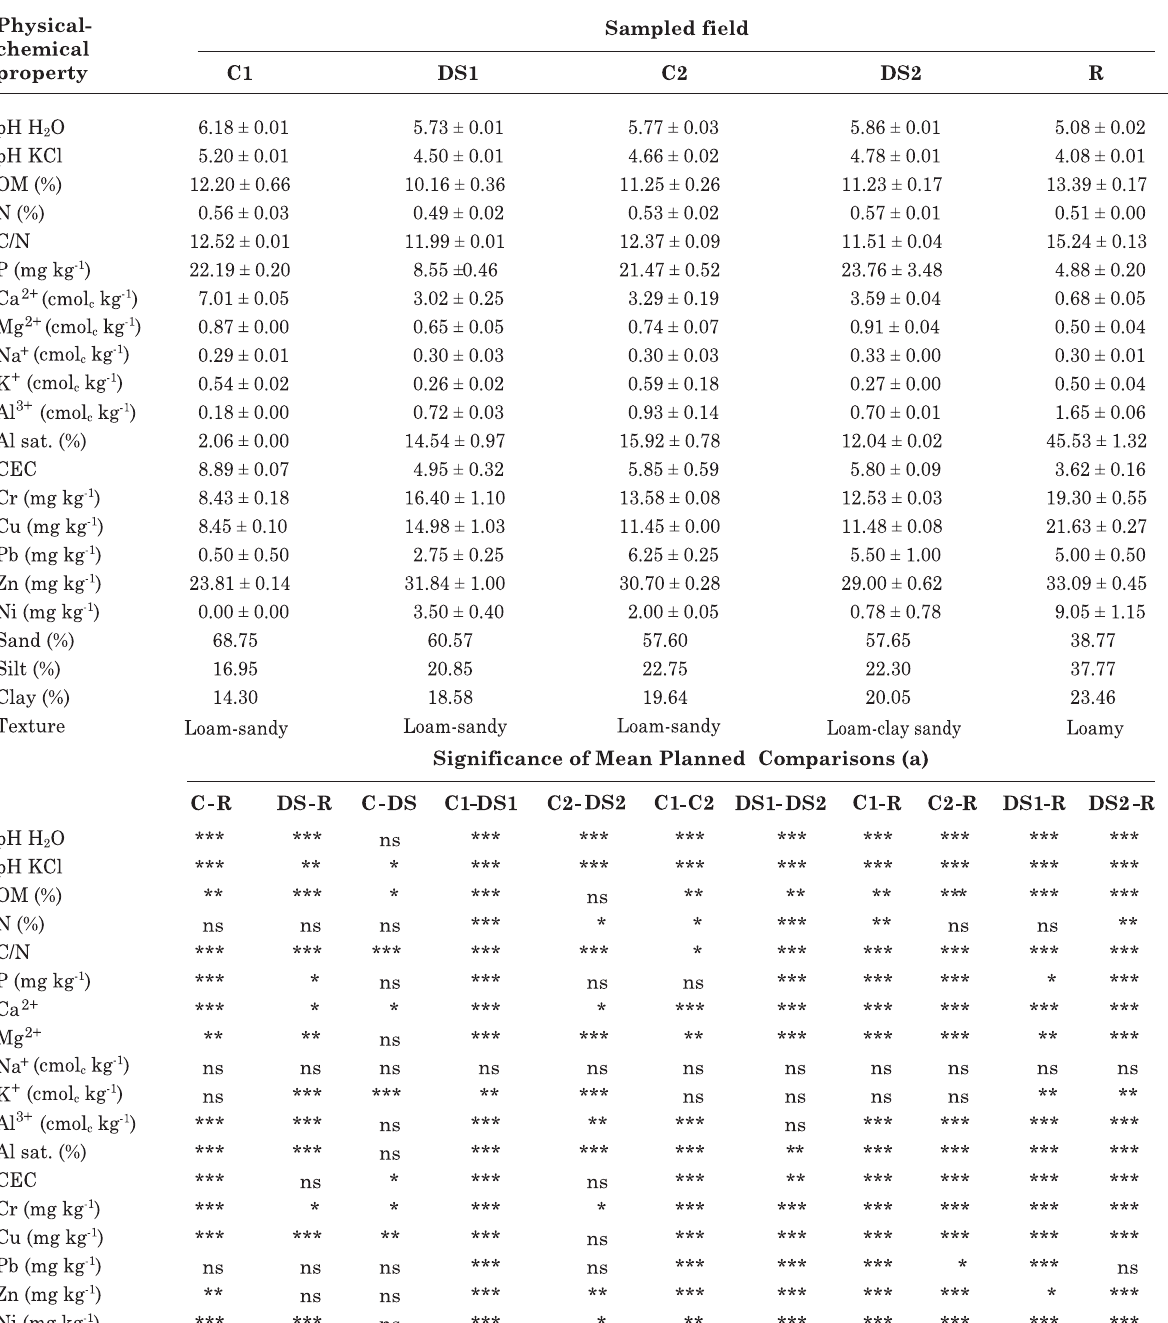
Table 1. Physical-chemical soil properties and mean comparisons between fertilization managements (mean ± standard